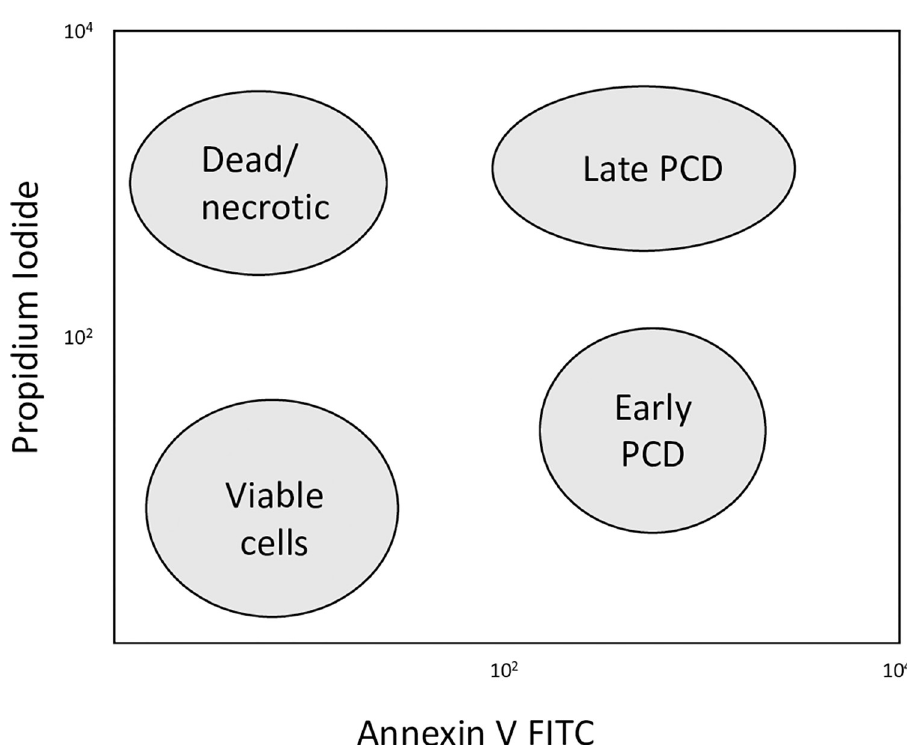
Fig 1. An example of a flow cytometry plot showing stages of cell death. Viable cells do not bind Annexin V or take up PI. Cells in early PCD bind Annexin V but still exclude PI. As the cell membrane becomes more permeable, cells in late PCD bind to Annexin V and PI. Dead or necrotic cells do not bind to Annexin V, but do take up PI.